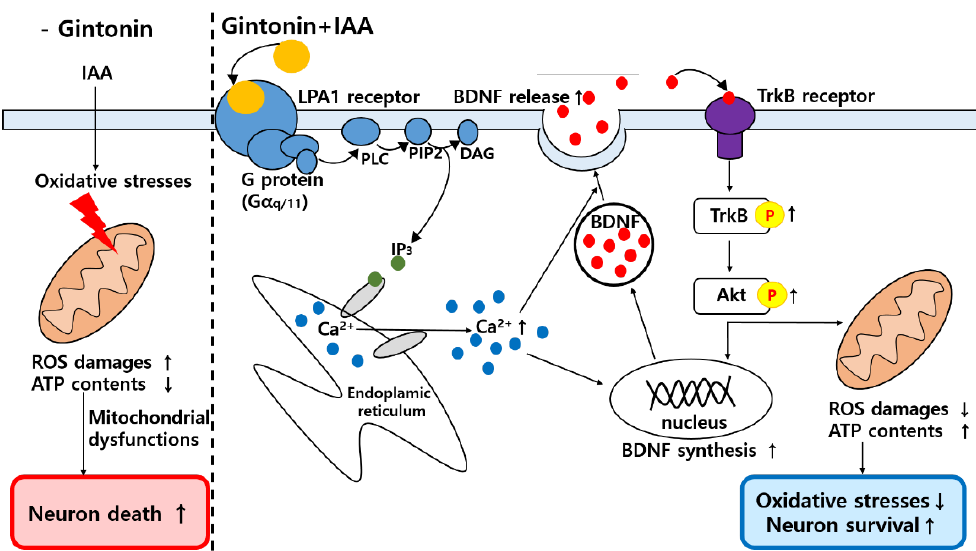
Figure 7. Schematic diagram of gintonin-mediated neuroprotective activity via LPA1 receptor activation under insults of oxidative stressor, IAA, in HT22 cells. Gintonin reduces reactive oxygen species (ROS) levels produced by IAA and has neuroprotective effects via LPA1 receptor-BDNF-TrkB-Akt signaling pathway.